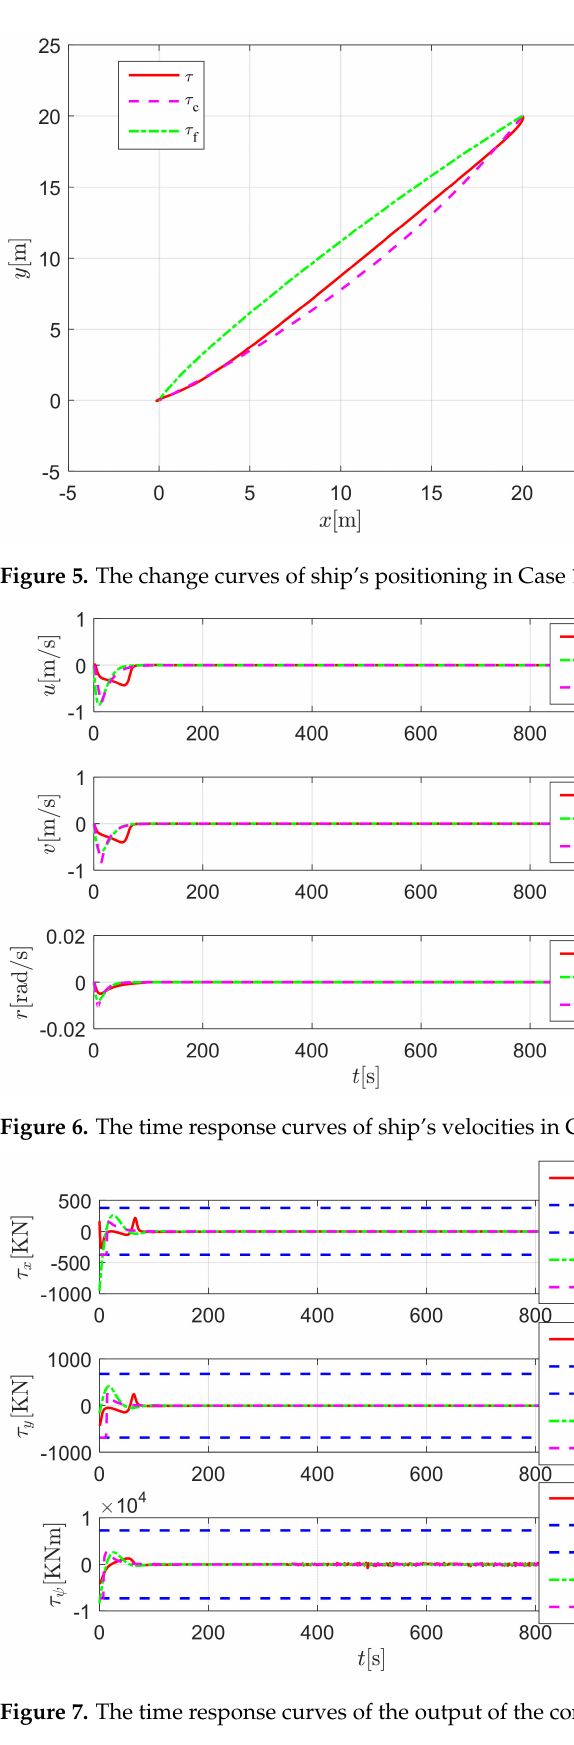
Figure 7. The time response curves of the output of the control laws in Case